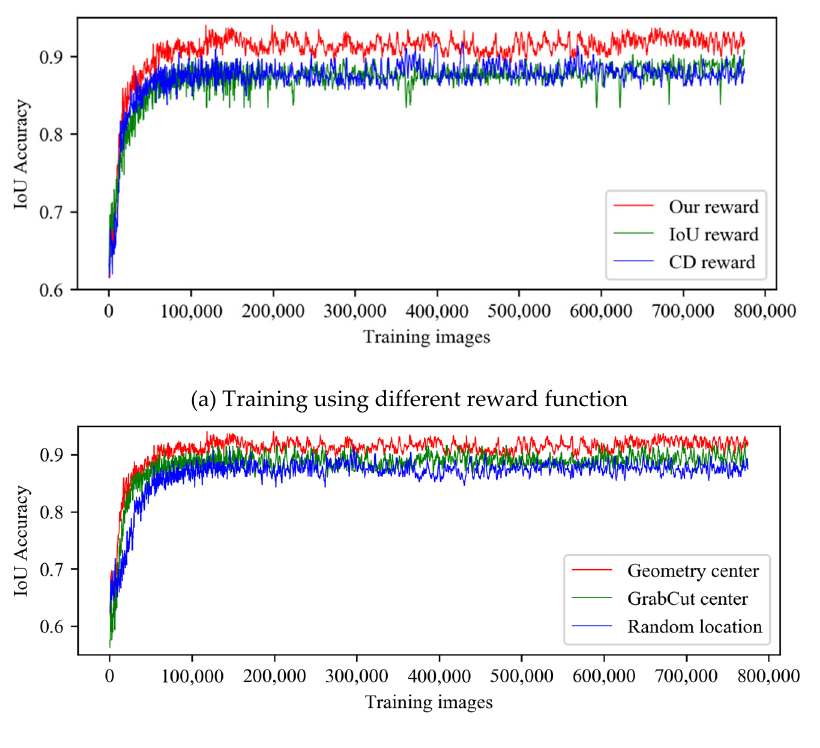
Figure 7. Ablation experiments. ( a ) shows IPL-Net learning progress using different reward function. ( b ) shows IPL-Net learning progress using different initial positions of the inside point.